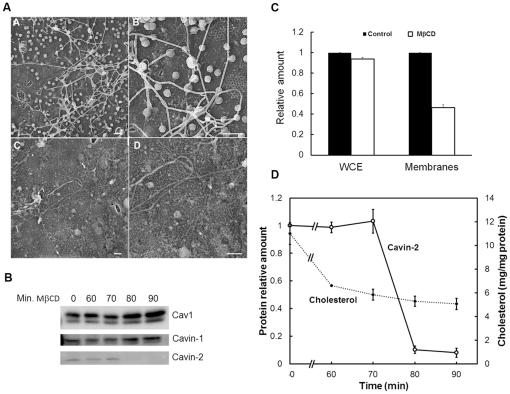
Cholesterol depletion collapses caveolae and causes loss of cavin-2 in a switch-like fashion (A).Freeze drying electron micrograph depicting the inner surface of the adipocyte plasma membrane before (panels A and B) and after (panels C and D) cholesterol depletion by 20 mM MβCD for 60 min. (left and right panels respectively, scale bar represents 200 nm). (B). 3T3-L1 adipocytes were treated with 20 mM MβCD for the indicated time points, lysates were prepared in RIPA buffer and analyzed by SDS-PAGE followed by Western blotting as described in Methods. (C & D). Cholesterol was determined as described in the Methods section for whole cell extracts and/or membranes (C, 90 min.) or at the times indicated (D) after MβCD exposure. The amount of cavin-2 was determined using a Fujifilm LAS-4000 Image Analyzer. The experiments of 1A, 1B and 1D are representative of >4 such experiments and C shows the mean ± S.E. for triplicate cell preparations. The value for cavin-2 at time zero was set to 1.0 and subsequent time points are expressed as ratios of this.